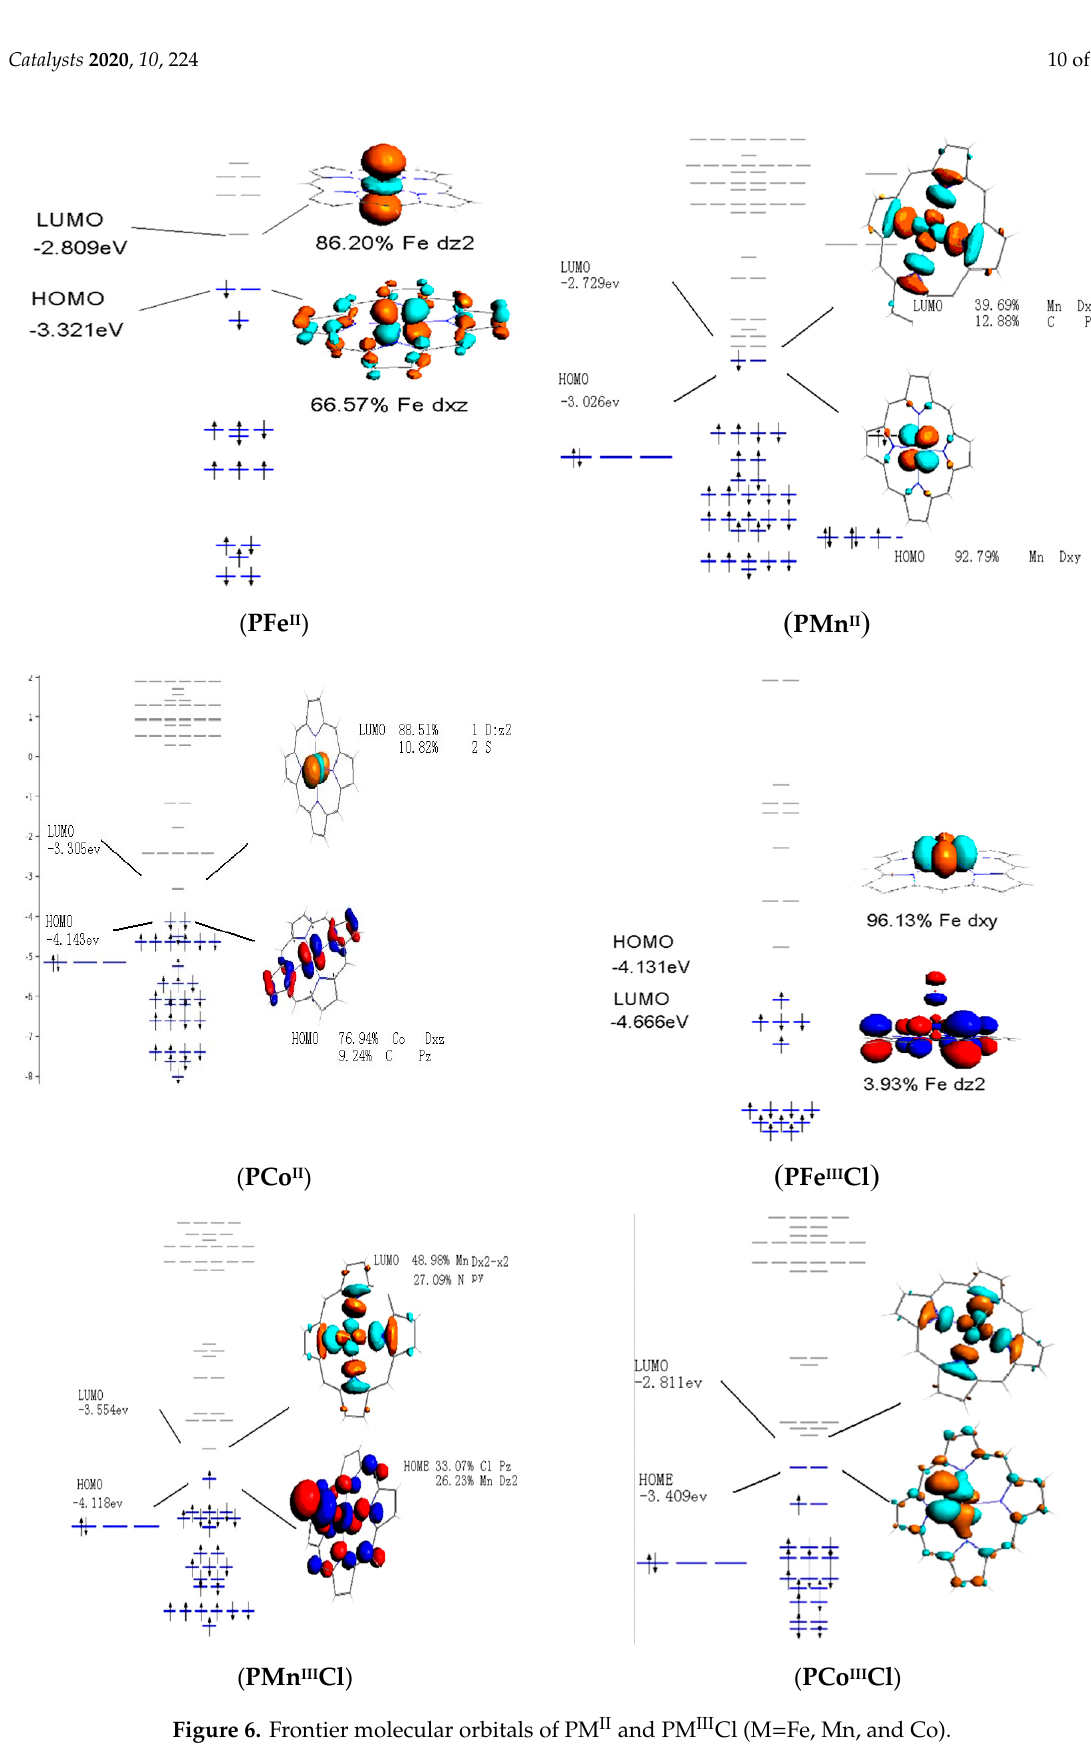
Figure 6. Frontier molecular orbitals of PM II and PM III Cl (M=Fe, Mn, and Co).